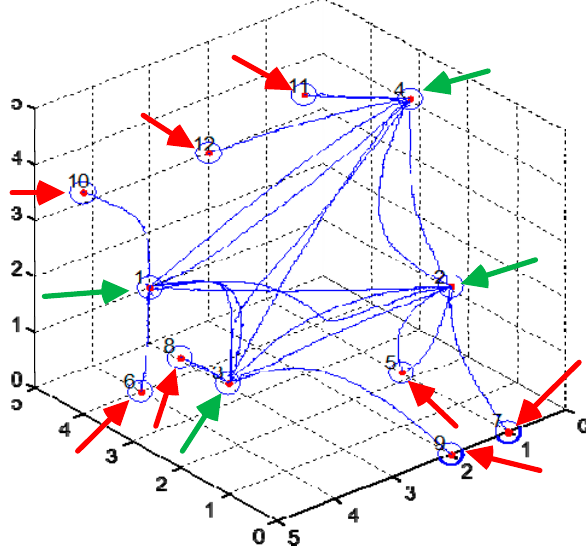
Figure 11. Twelve randomly distributed neurons and the connection structure arising from the network.